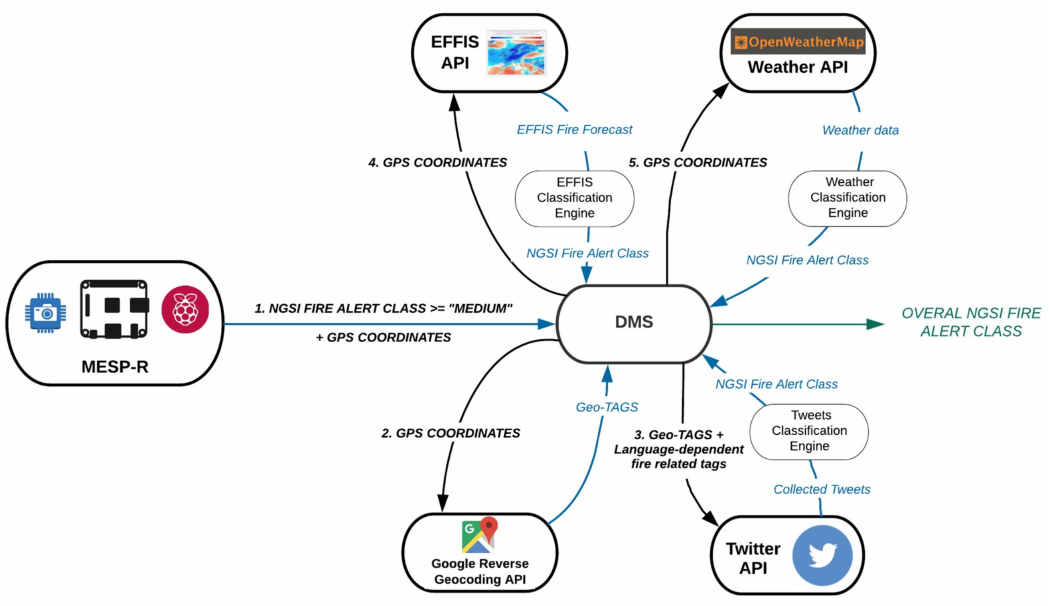
Figure 13. The sequence followed for the decision-making